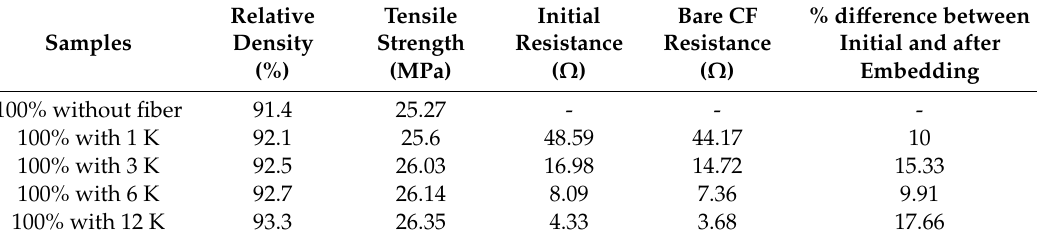
Figure 11. ABS sample with embedded carbon fiber as a sensor. Table 1. ABS samples’ specifications.